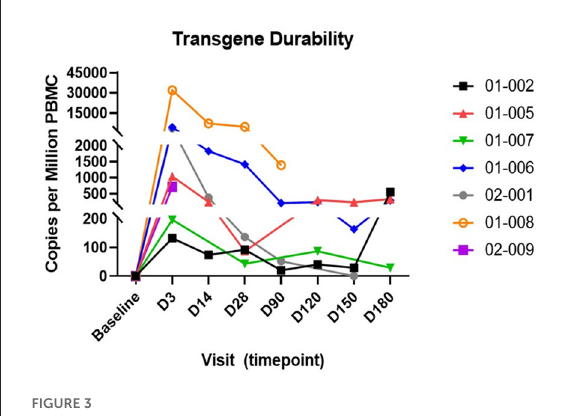
FIGURE3 Persistence of genetically modified AGT103-T cells in participants post infusion. Transgene (AGT103 vector) durability is expressed as copies per million PBMC. Dashed line